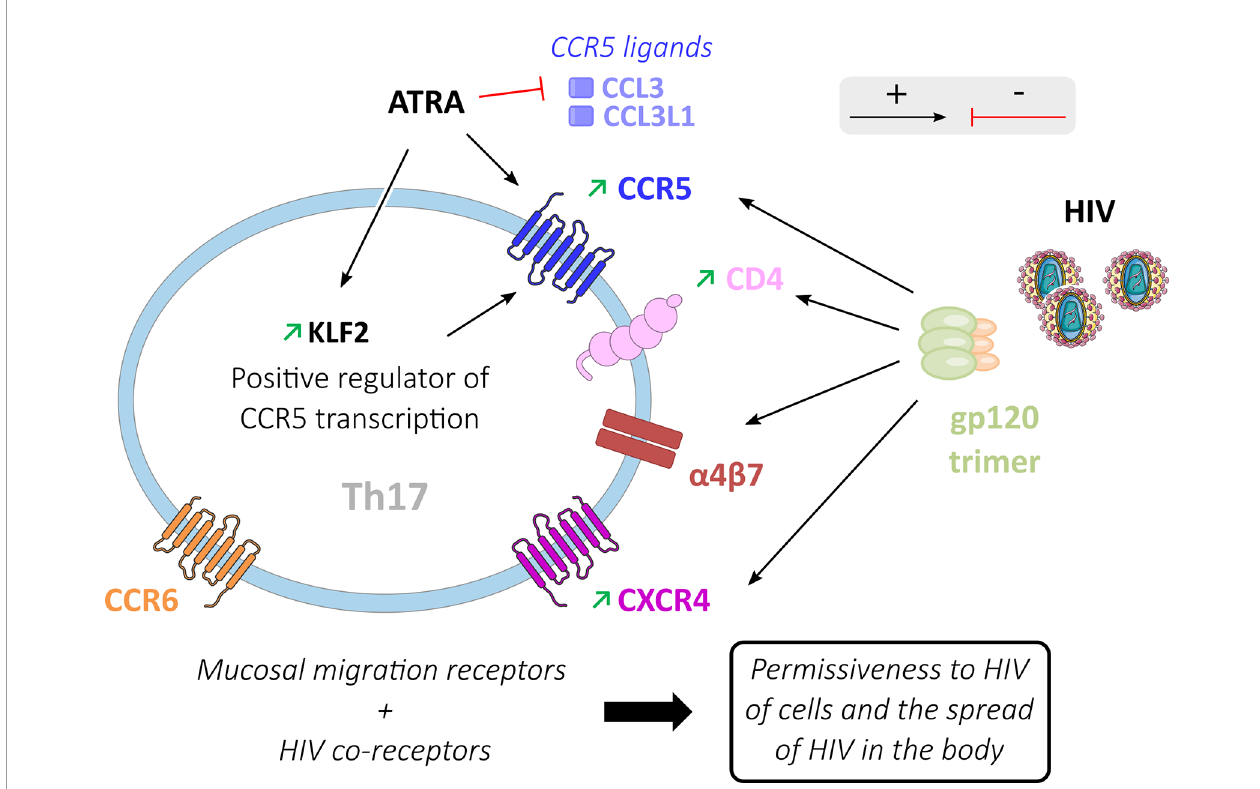
FIGURE 3 | HIV entry process in Th17 cells. Activating (black arrows) or inhibiting (red arrows) factors are involved in HIV entry into Th17 cells. Mucosal migration receptors ( a 4 b 7 and CCR6) and HIV gp120 binding to co-receptors (CD4, CCR5, CXCR4 and a 4 b 7) increase HIV permissiveness in these Th17 cells where these receptors are preferentially expressed. ATRA inhibits the production of classical ligands of the CCR5 receptor (CCL3, CCL3L1) thereby promoting the interaction of CCR5 with gp120. ATRA also increases the expression of KLF2 in Th17 cells, a positive regulator of CCR5